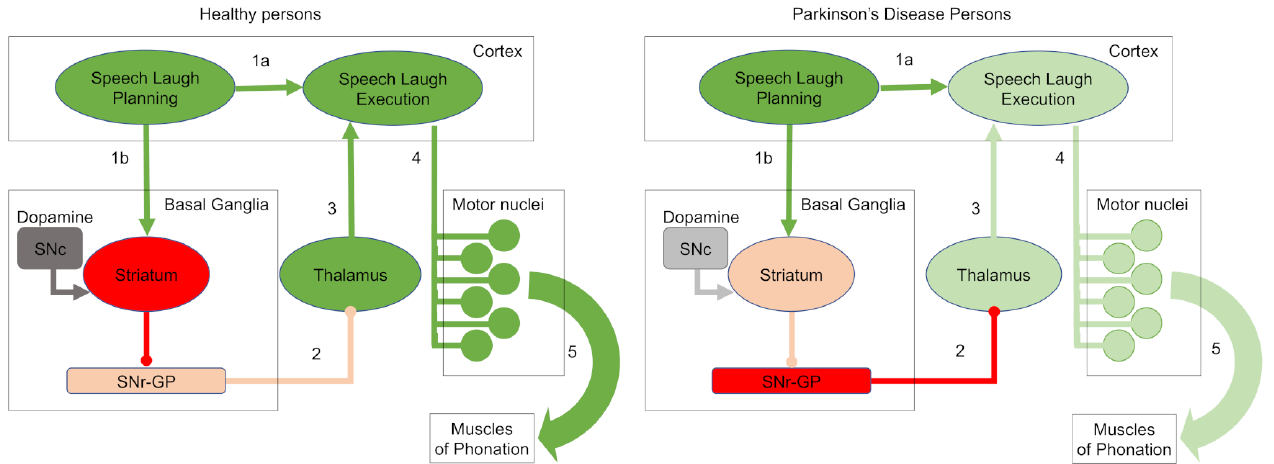
Figure 1. Simplified representation of how Parkinson’s disease affects speech and laughter. Speech/laughter decision-making cortical areas activate the motor commands–execution circuit ( arrow 1a ) as well as the basal ganglia–thalamus circuit ( arrow 1b ), which modulates the activity of these commands ( arrow 3 ). Motor commands–execution areas send their output ( arrow 4 ) to the motor nuclei which control muscles that generate speech/laughter sounds ( arrow 5 ). In green, excitatory neuronal activity; in red, inhibitory neuronal activity; in grey, activity of dopaminergic neurons. Intense color indicates high neuronal activity; light color indicates low neuronal activity. In healthy subjects ( left scheme ), SNc-produced dopamine excites striatum neurons that inhibit SNr-GP inhibitory neurons. Low inhibitory input to the thalamus ( arrow 2 ) is the ideal condition for the correct modulation of the motor commands ( arrow 3 ), as well as the coordination of the motor nuclei ( arrow 4 ) and of the corresponding muscles ( arrow 5 ). In Parkinson’s disease ( right scheme ), the reduced SNc dopamine slows down striatum neurons, increasing SNr-GP inhibitory output ( arrow 2 ). The inhibited thalamus fails in the modulation of cortical nuclei ( arrow 3 ), losing the coordination of the motor nuclei ( arrow 4 ) and provoking motor disorders ( arrow 5 ). SNc, substantia nigra compacta; SNr, substantia nigra reticulata; GP, globus